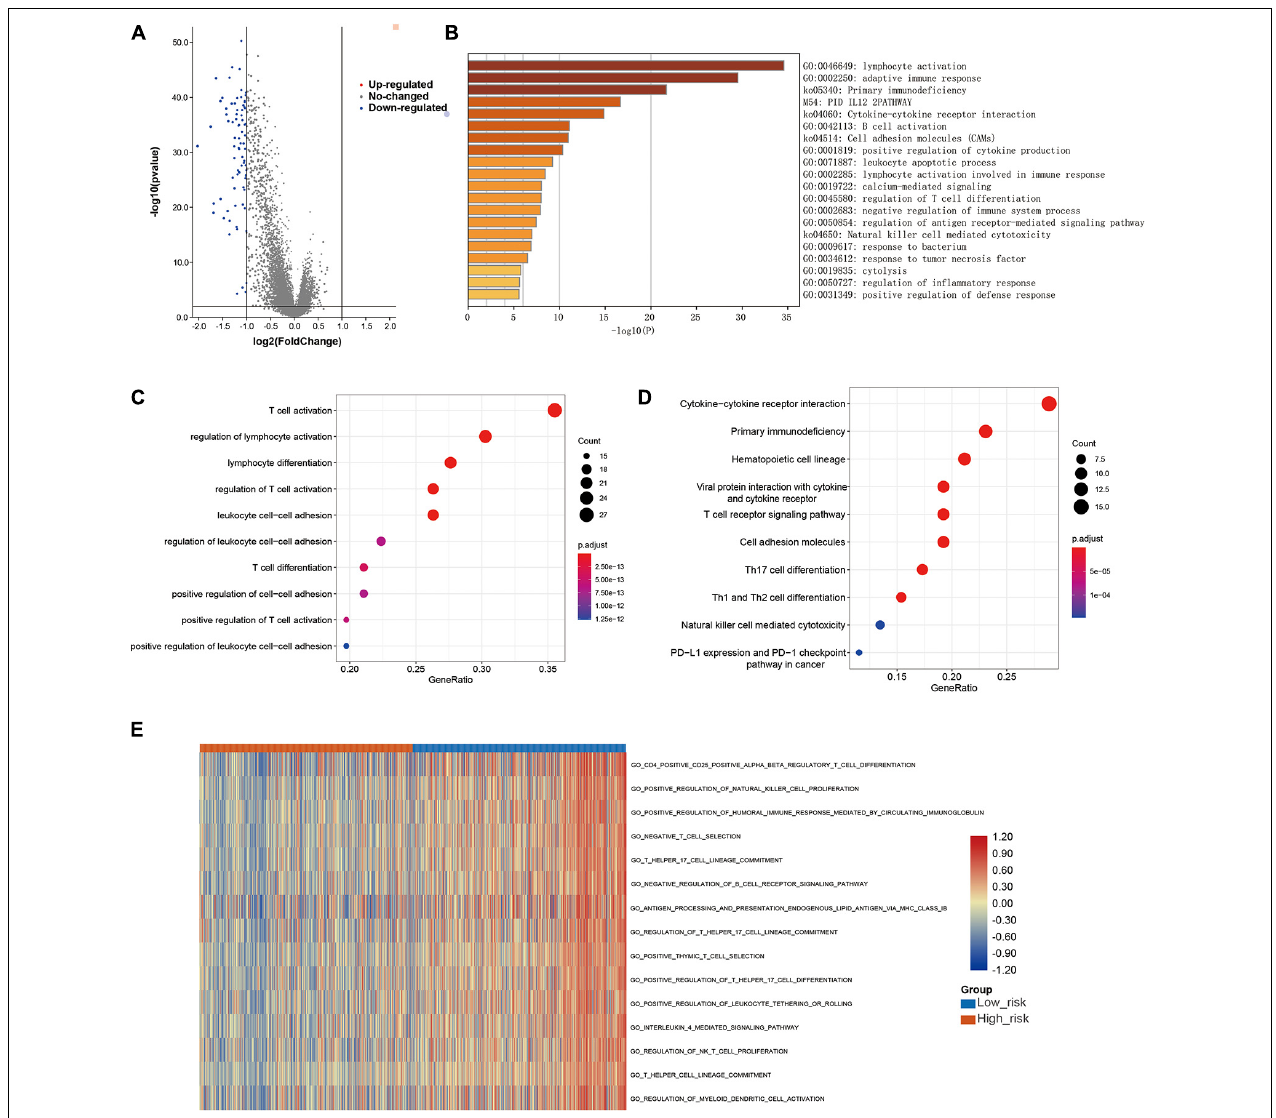
FIGURE 9 | Functional analyses. (A) Volcano plot depicting the differentially expressed genes (DEGs) between the two groups, (B,C) bubble plot derived from gene ontology (GO) analysis suggesting that the DEGs were mainly enriched in immune-associated biological processes, (D) bubble diagram derived from Kyoto Encyclopedia of Genes and Genomes (KEGG) analysis showing that the DEGs were enriched in immune-associated signaling pathways, (E) GSVA plots visualizing the result of GSVA